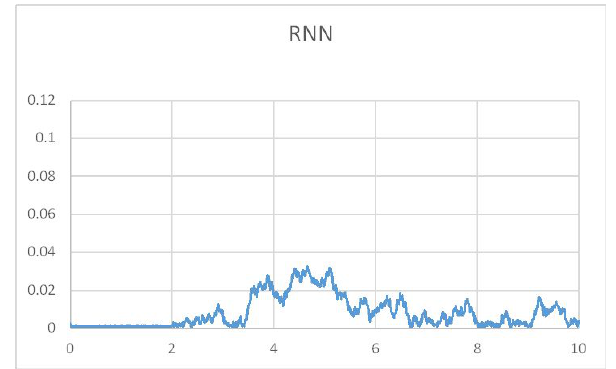
Figure 11. Delays on the path 2–11: DW method.